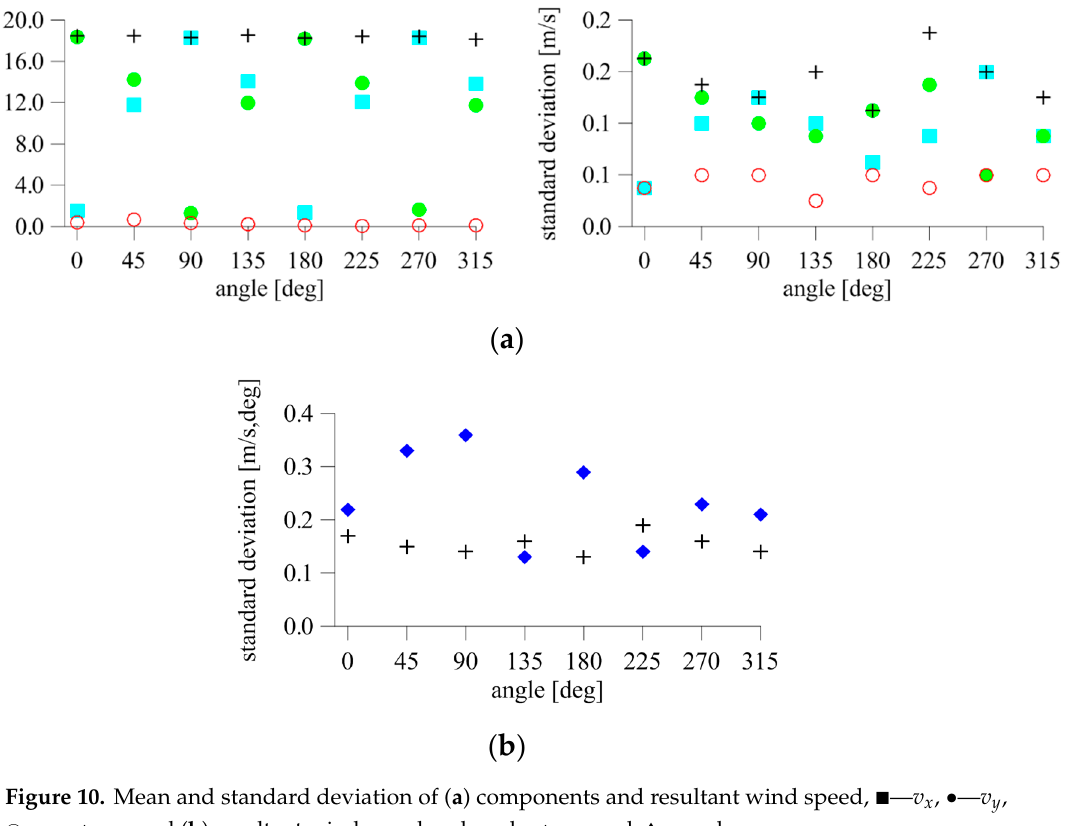
Figure 9. Fluctuations of wind speed: ( a ) components and resultant, for α = 135°; ( b ) resultant for all angles.